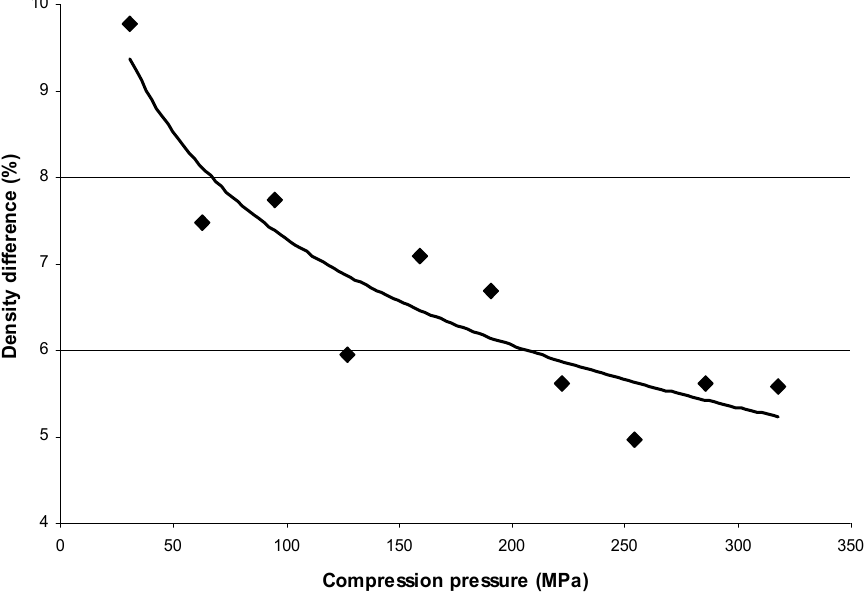
Figure 9. Density difference, dependent on pressing pressure ( w r = 8%; L = 2